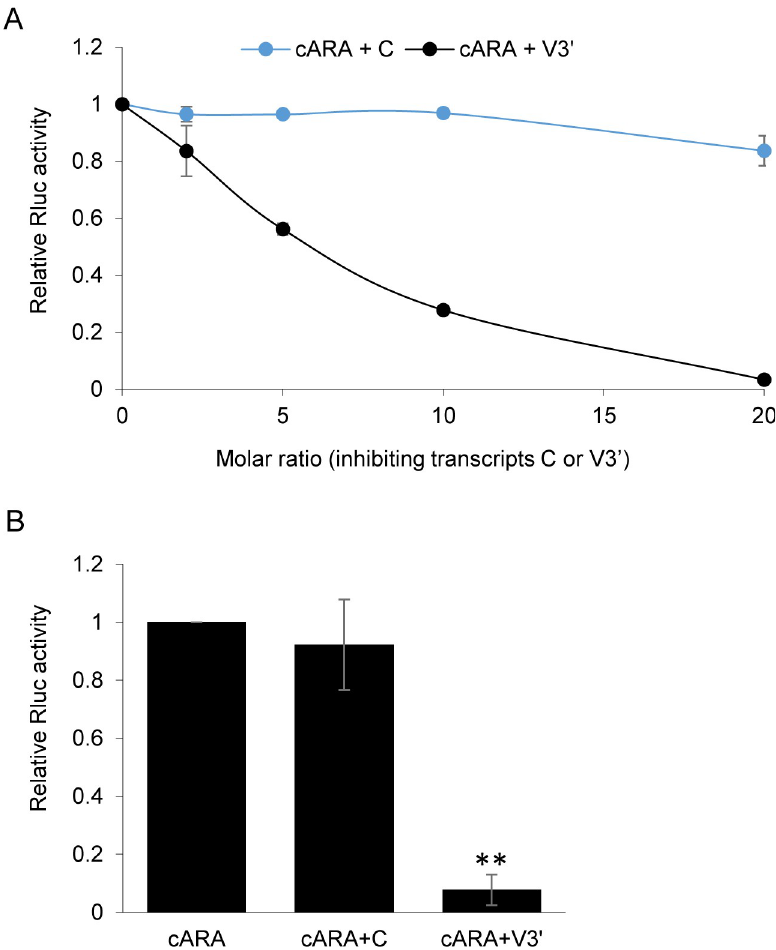
Fig 6. Translation of capped ARA control transcripts is inhibited by the viral 3’ UTR supplied in trans . (A) Luciferase assay showing translation inhibition of capped reporter transcripts (cARA) with increasing concentration of viral 3’ UTR (V3’) supplied in trans . Reporter transcript (cARA) was used at a concentration of one picomole per 50 μ l of WGE translation reactions. Either a control transcript (C, derived from vector sequences) or the V3’ transcript were supplied at various concentrations (0, 2, 5, 10 and 20 picomoles per 50 μ l of translation reactions) and the luminescence was measured after in vitro translation. The luminescence values of reporter transcripts with added inhibitory transcripts (C or V3’) were normalized to those obtained for the cARA in the absence of inhibitory transcripts. Results are shown as the average values obtained from two independent experiments, each with three technical repeats. Error bars represent the standard deviation. (B) Inhibition of translation of cARA transcripts in the presence of a 20-fold excess of control or viral 3’ UTR provided in trans . Translation reactions were programmed as in A with 1 picomole of cARA transcripts and 20 picomoles of either V3’ or C transcripts. Translation of cARA was reduced significantly ( �� , P < 0.001) in the presence of 20 picomoles of V3’ transcripts (Student’s t-test, two-tailed, n = 3). Results are shown as an average of three independent experiments, each with three technical repeats. Error bars indicate the standard